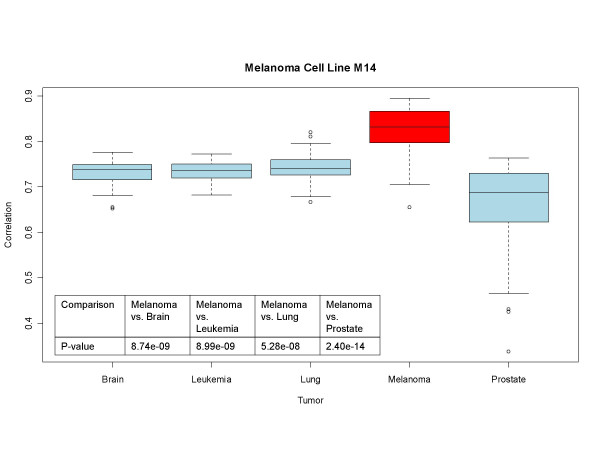
Melanoma cell line M14 represents its corresponding tumor type, as suggested by correlations of gene expression profiles between the cell line and primary tumors. The y-axis represents Pearson's correlation coefficients of gene expression profiles between the cell line and primary tumors. Labeled on x-axis are tumor types. Presumed tumor origin for the cell line is red-colored. The p-values of ANOVA tests for mean correlation coefficients are indicated in the table.